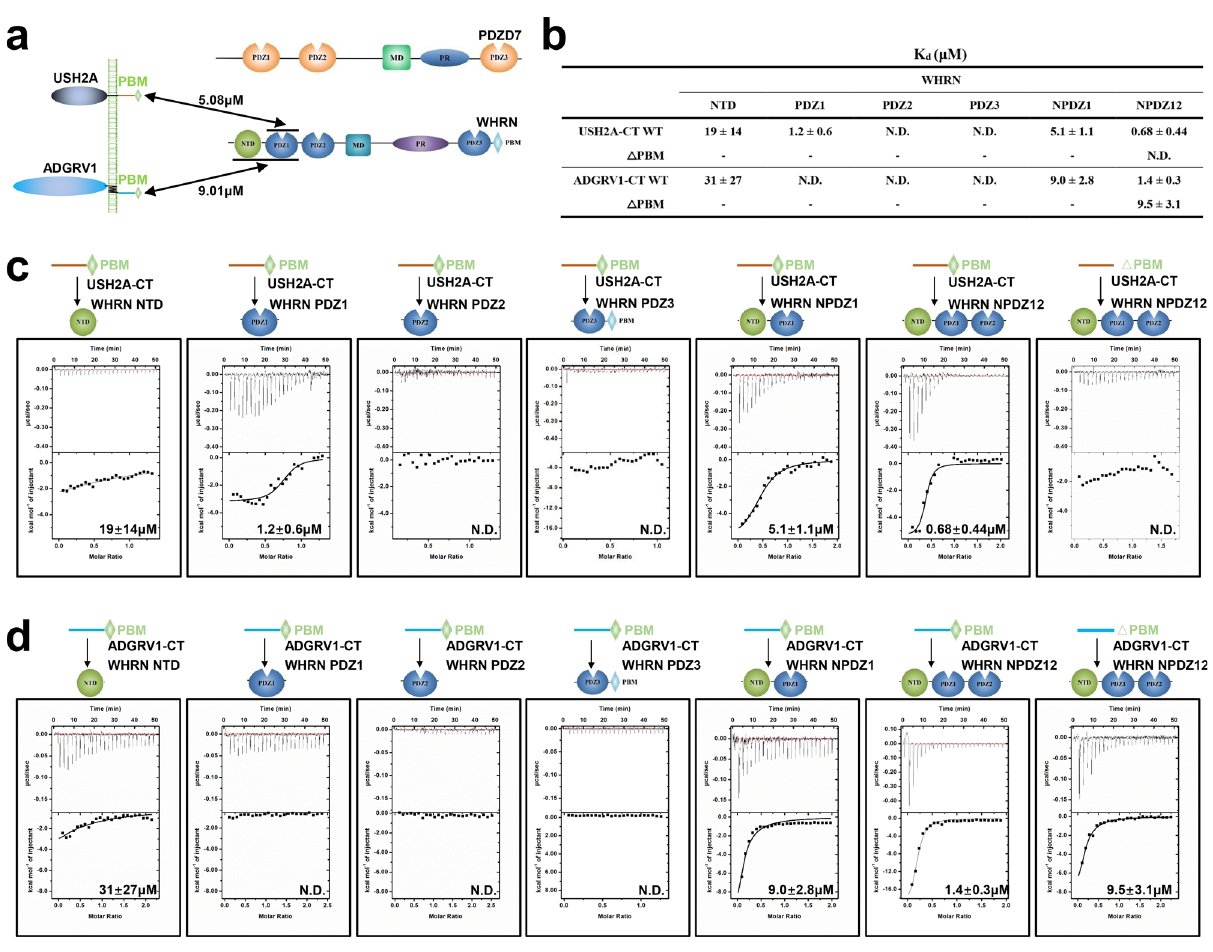
Fig.1|CharacterizationofthebindingselectivitybetweenWHRNwithADGRV1 and USH2A. a The schematic diagram shows the interactions between WHRN and USH2A-CT, ADGRV1-CT. b Summaries of the binding af fi nities between WT or △ PBM constructs of USH2A-CT, ADGRV1-CT, and different WHRN fragments. c , d Binding af fi nities of USH2A-CT (C) or ADGRV1-CT (D) to different WHRN